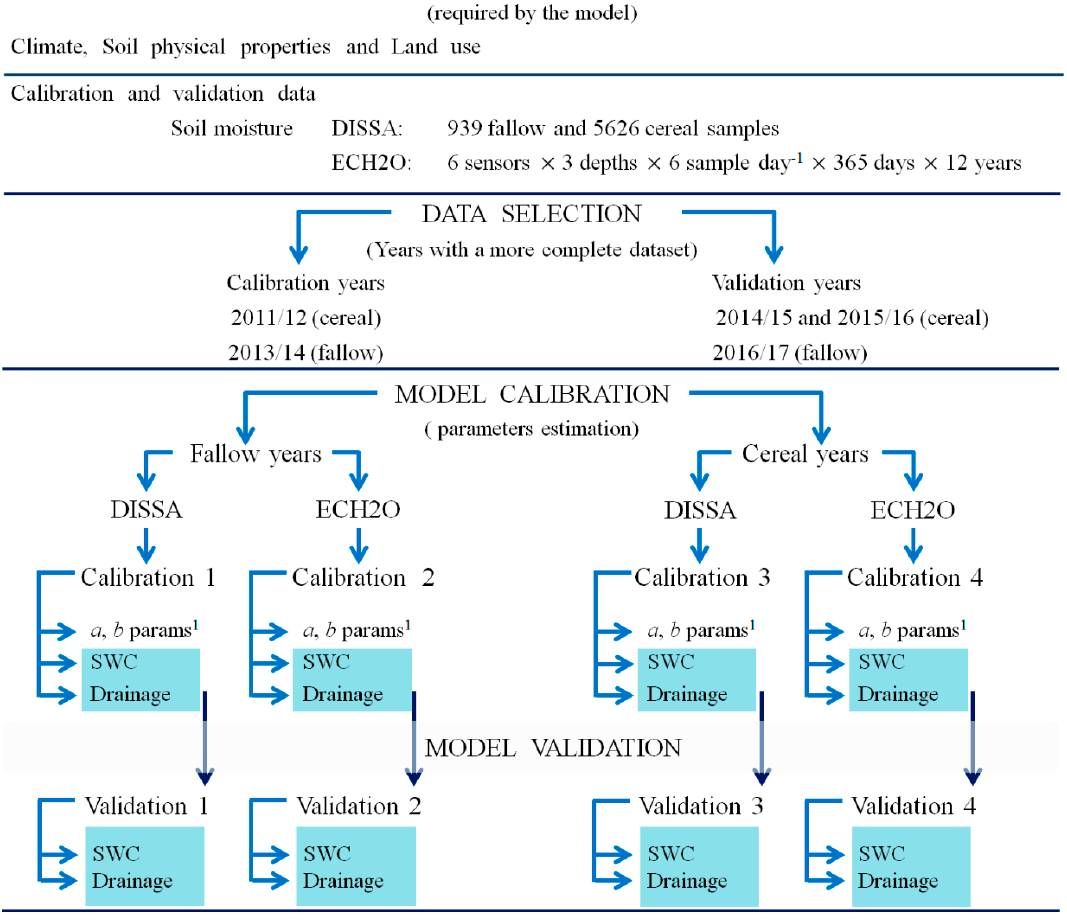
Figure 3. General scheme of the applied methodology for data acquisition and the evaluation process to model water dynamics in soil (drainage and soil water content (SWC)) from disturbed soil samples (DISSA) and from frequency domain reflectometry probes (ECH2O). The a and b parameters 1 belong to the functions defining soil water retention and hydraulic conductivity.